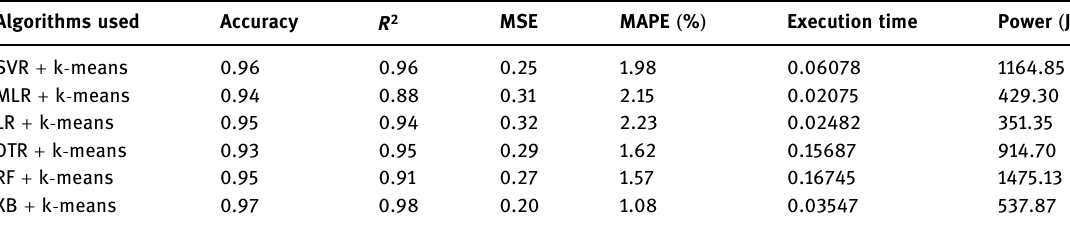
Table 1: Comparison of performance metrices obtained from various ML algorithms Algorithms